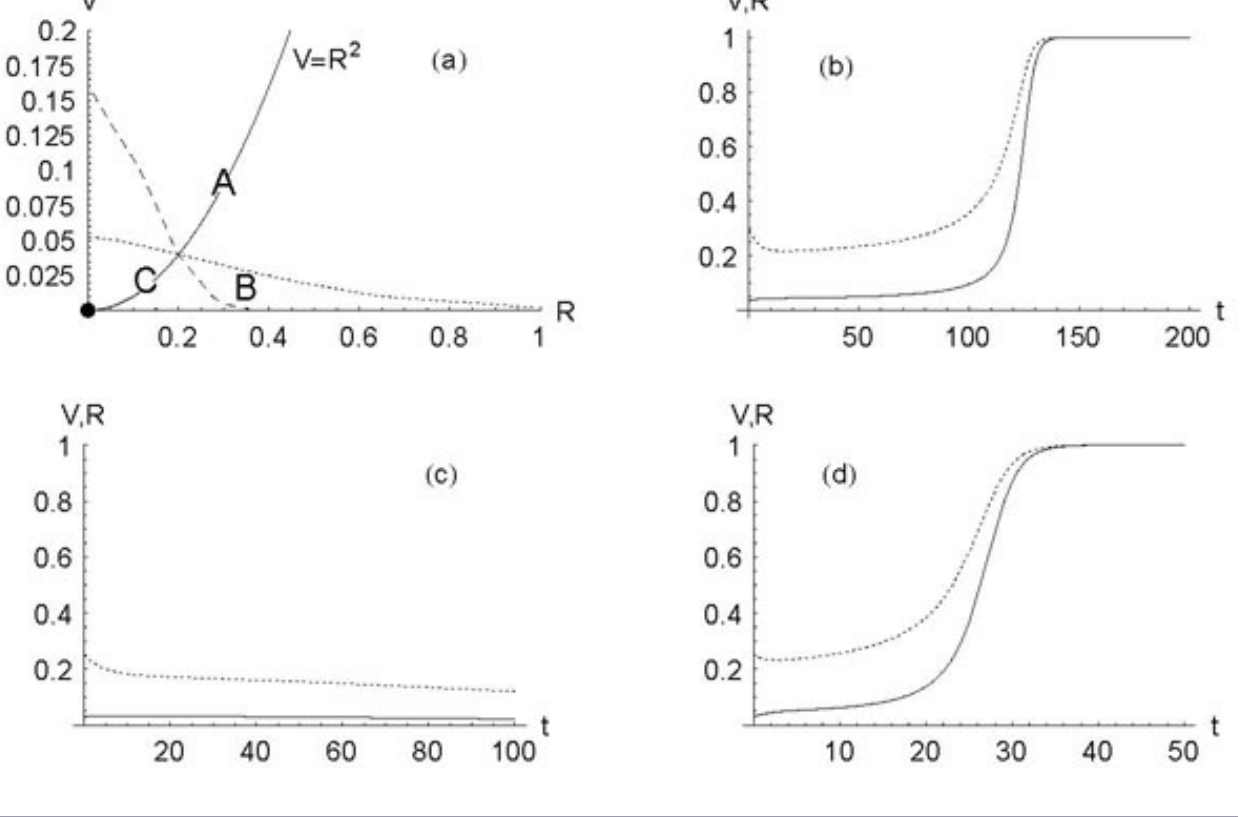
= 0 „ 0 0 = 0 and initial conditions 0